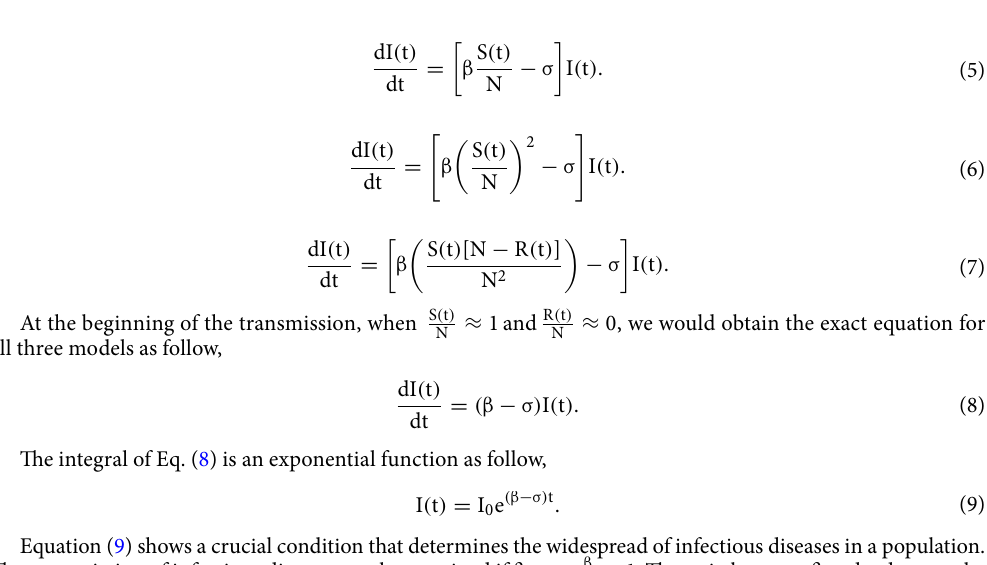
Figure 3. The compartmental structure and model equations of vaccine models modified using the conventional SIR model, Model A and Model